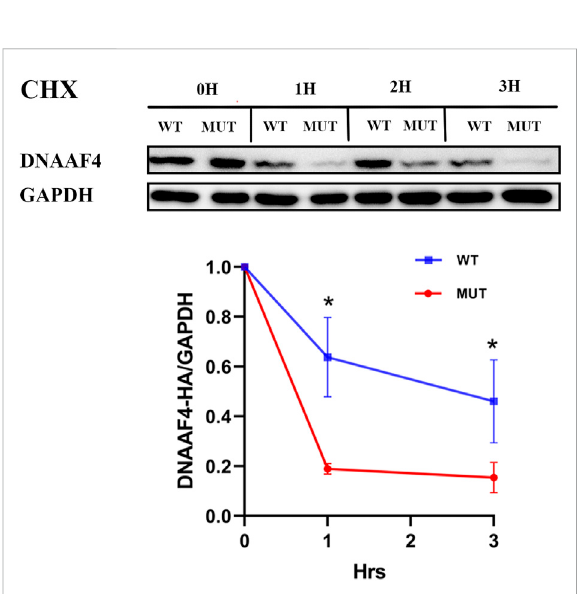
FIGURE 4 Effect of the Mutation on the Stability of the DNAAF4 Protein. (Top panel) Forty-eight hours after transfection of HEK293T with plasmid, then CHX added, Western blot showed the expression of DNAAF4 protein at 0, 1, 2, and 3 h after addition of CHX. GAPDH is shown as a reference. (Bottom panel) Quanti fi cation of the DNAAF4-HA stability relative to GAPDH for this experiment. The densitometric ratio of DNAAF4-HA to GAPDH at the time of addition of CHX is established as 100% and the ratio of the DNAAF4-HA to GAPDH at 1 and 3 h is compared to time 0. *, p < 0.05.